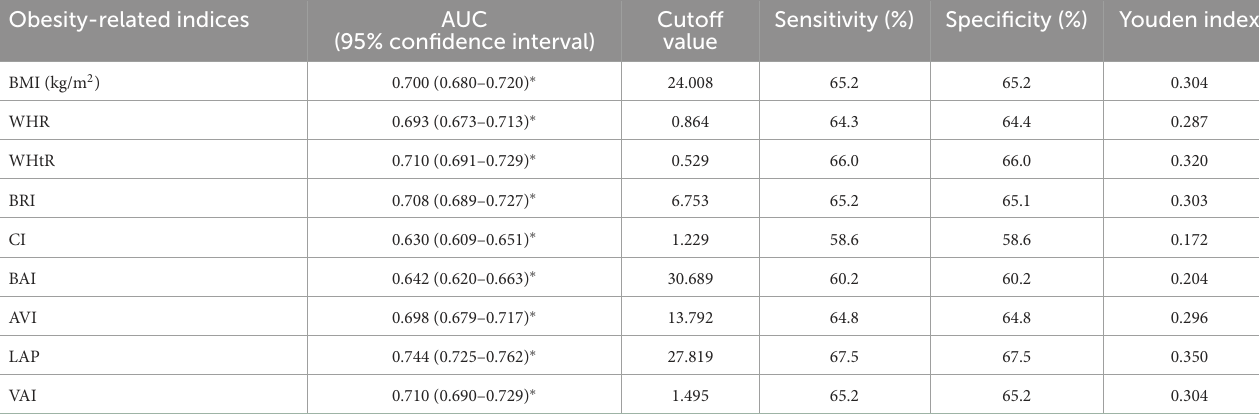
TABLE 5 Area under curve (AUC), cutoff value, sensitivity, specificity, and Youden index of 9 obesity-related indices for incidence of DM in female participants. Obesity-related